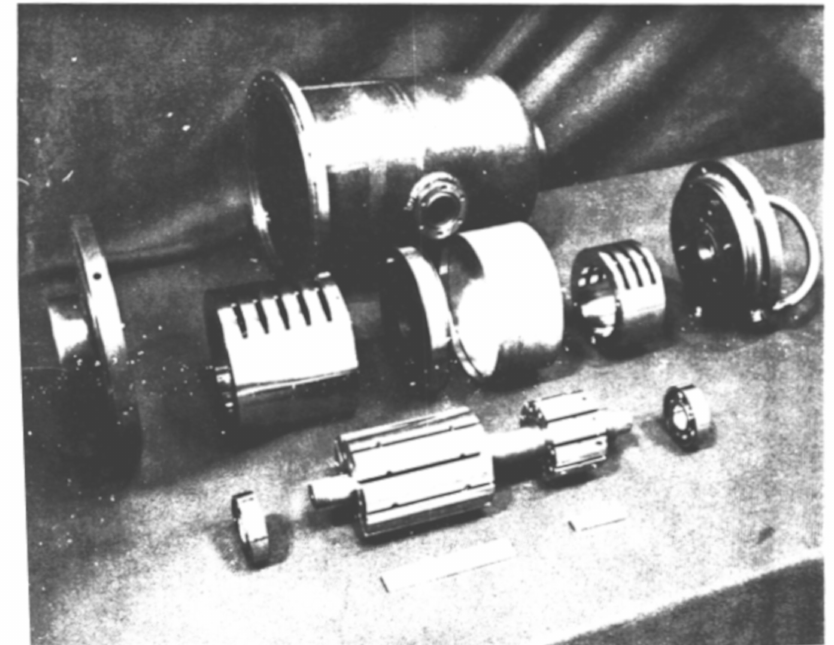
Figure 3. A general view of the two-stage multi-vane expander, which was tested by the General Electric Company in the late 1970s [44]. This figure is taken from Prototype Solar Heating and Combined Heating and Cooling Systems; DOE / NASA Contractor Report No. DOE / NASA CR-161340 and used with permission of